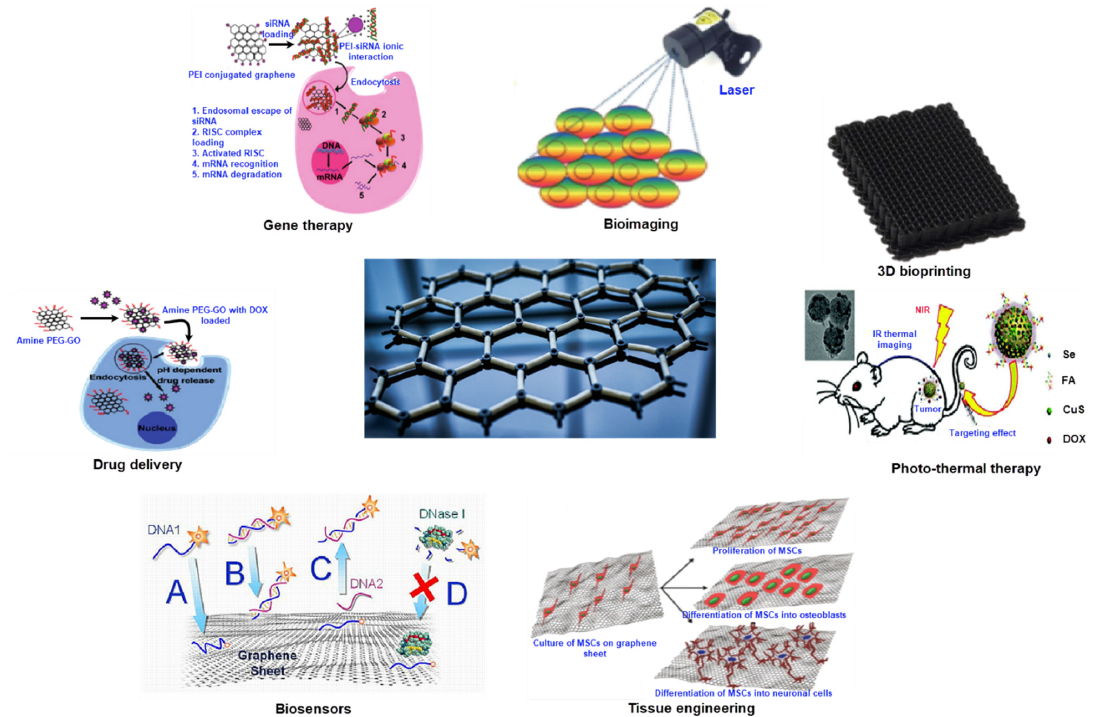
Figure 15. Applications of graphene-based materials in medical and healthcare; Reprinted with permission from [263]. Table 6. The potential applications of graphene/polymer composites in the biomedical